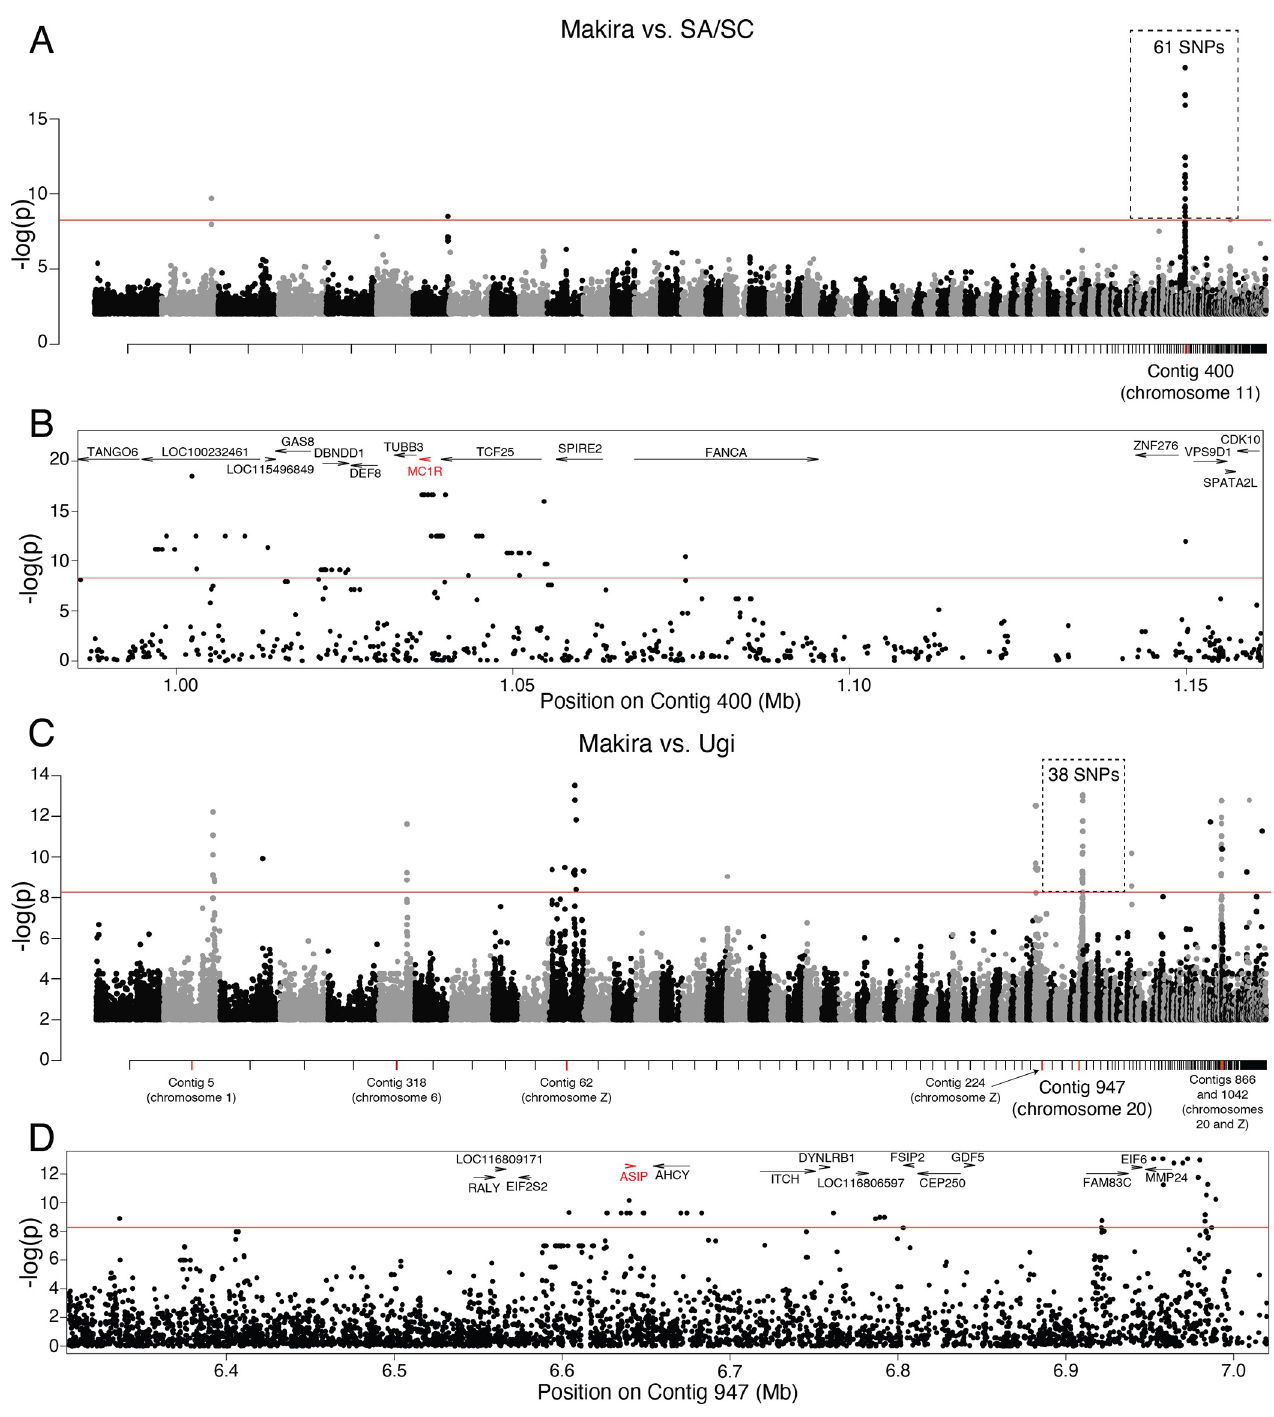
Fig 2. Genome Wide Association Study. A . Manhattan plot obtained from the GWAS comparing individuals from Makira and SA/SC. B . Zoom-in to the association peak in A indicating gene annotations within this region with MC1R in red. Equivalent plots for the GWAS obtained with individuals from Makira and Ugi ( C , D